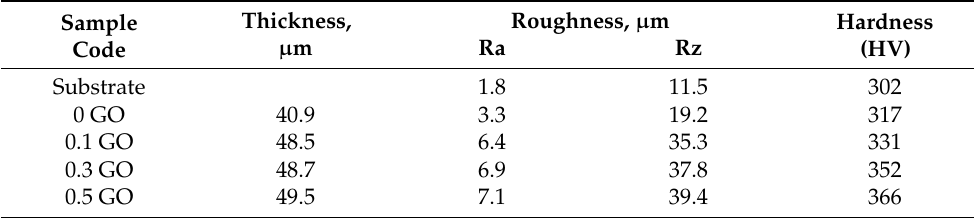
Table 3. Thickness, roughness, and hardness (HV) of MAO coatings.